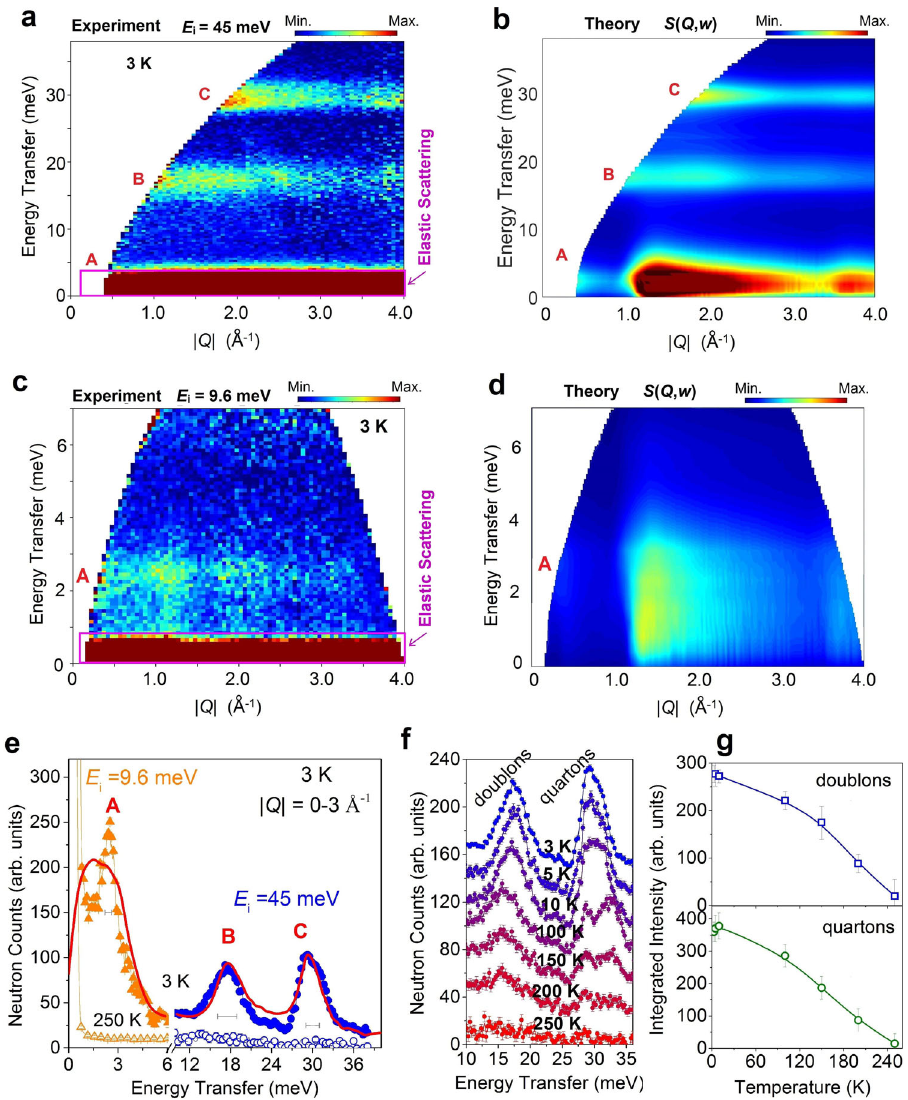
Fig. 3 | Dynamic structure factors of composite and spinon excitations in Na 2 Cu 3 Ge 4 O 12 powders.a , c False-colourmapsoftheINSintensitymeasuredat T = 3K on the MERLIN spectrometer at ISIS facility, RAL, UK (in the 1D magnetic state above the T N = 2.25K) using a fi xed incident energy of E i = 45 and 9.6meV, respectively (see ‘ Methods ’ ). The INS spectra have had an estimated phonon con- tribution subtracted (see ‘ Methods ’ ). The intensities are denoted by different col- ours, asindicatedby the scalesateach panel.The magenta boxesatthe bottom of theeachpatternsrepresenttheareaswheretheelasticscatteringcontributionsare evident. b , d The excitationspectrafor the spin-1/2 antiferromagnetictrimer-chain